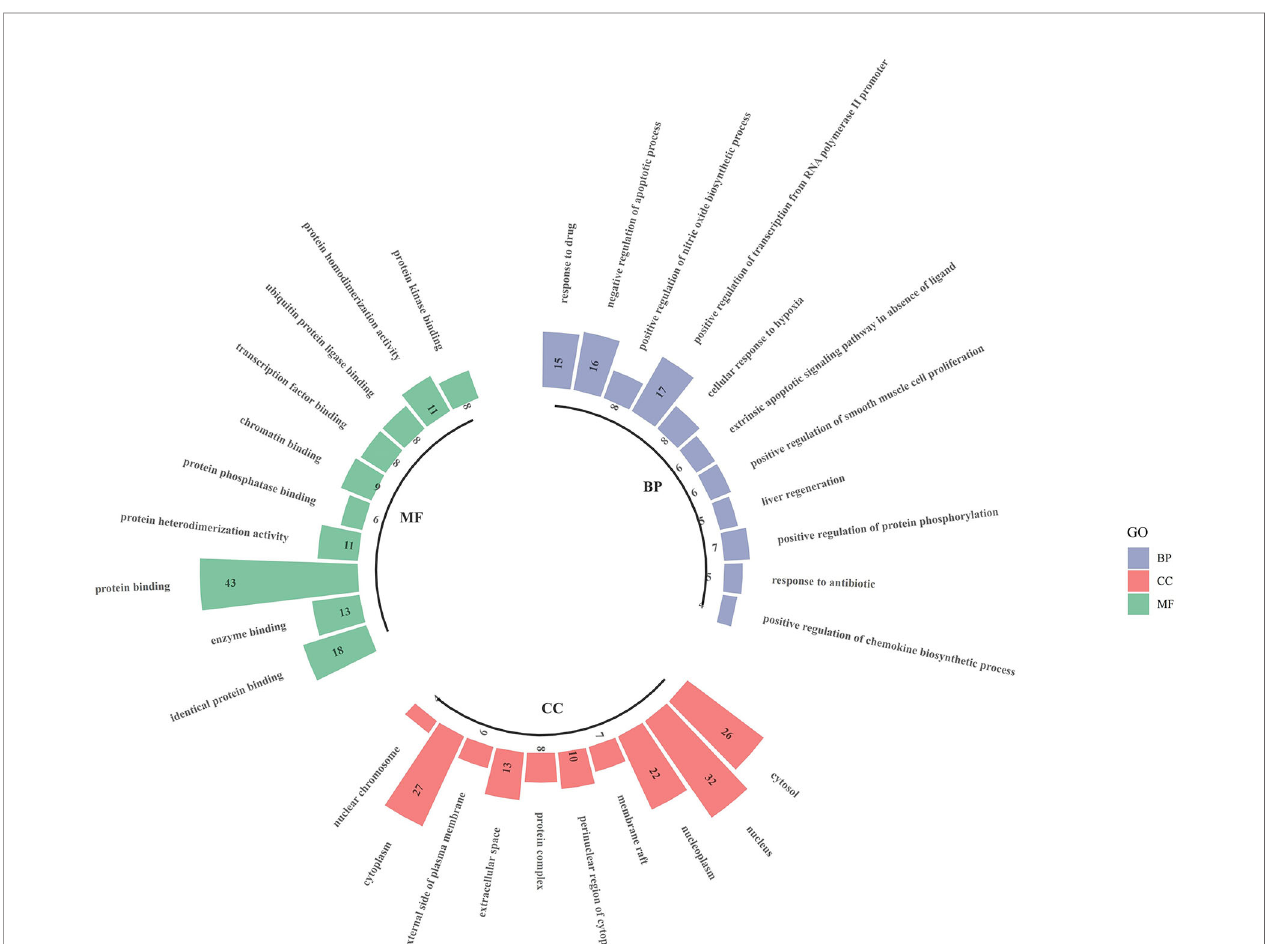
FIGURE 6 | Go enrichment analysis for targets of Luteolin against OP (TOP